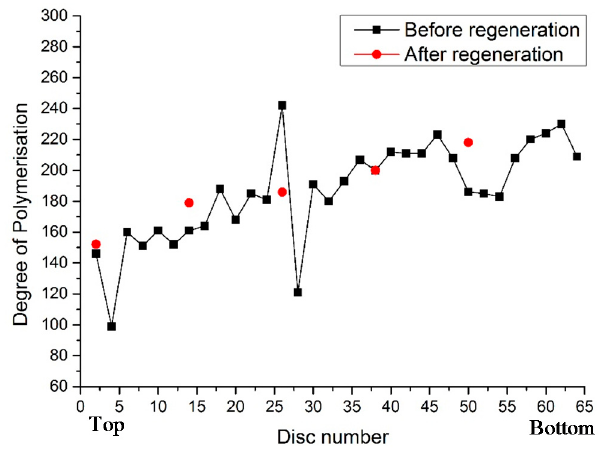
Figure 10. Profile of DP of paper before regeneration, and at the end of stage 2.